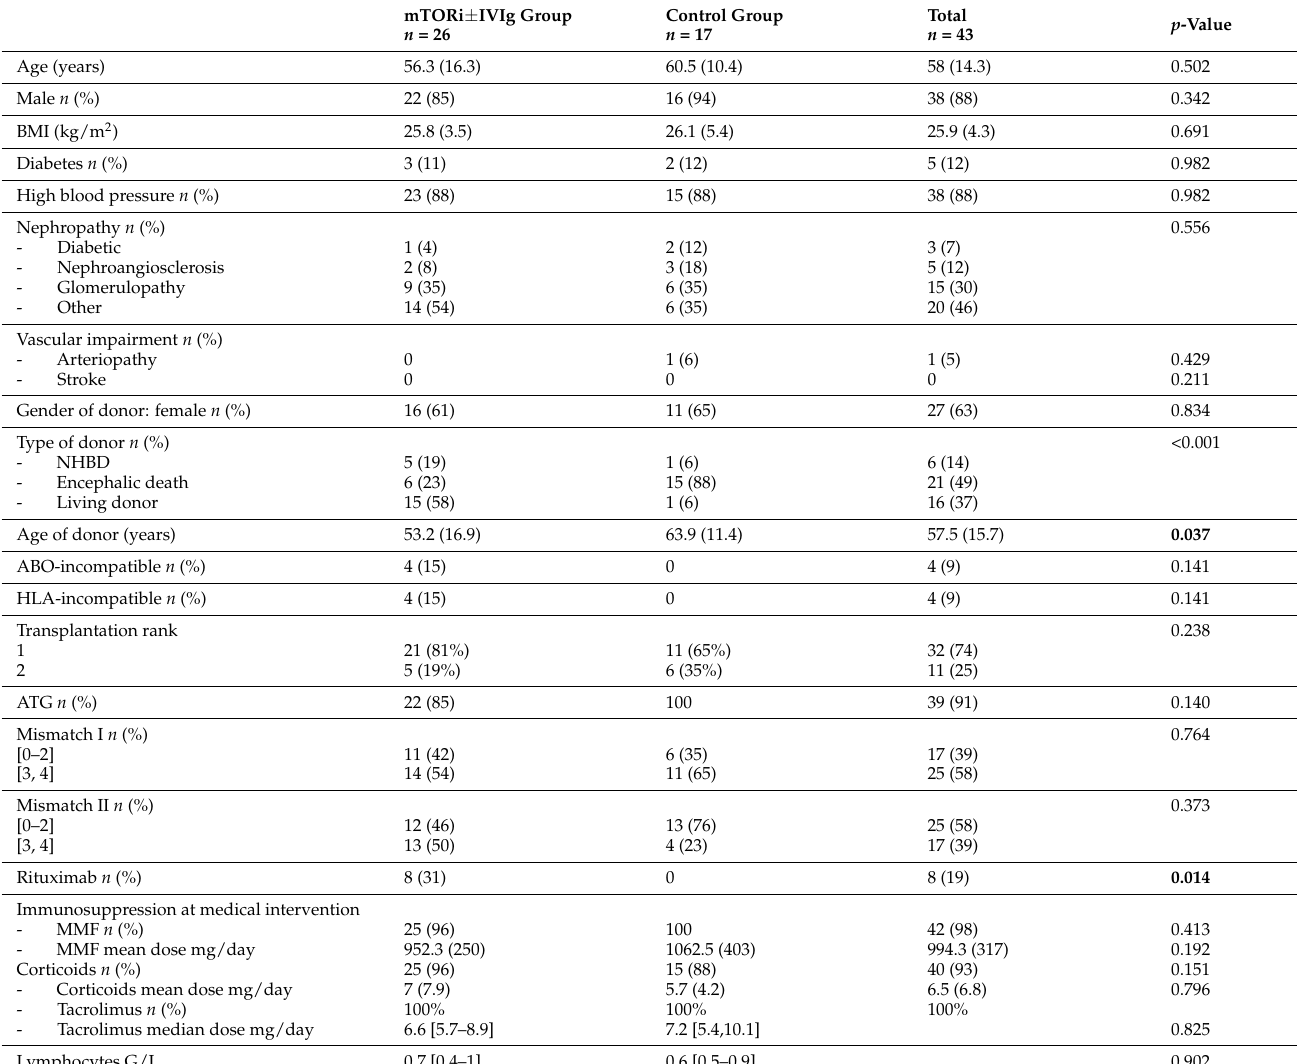
Table 1. Baseline characteristics of the